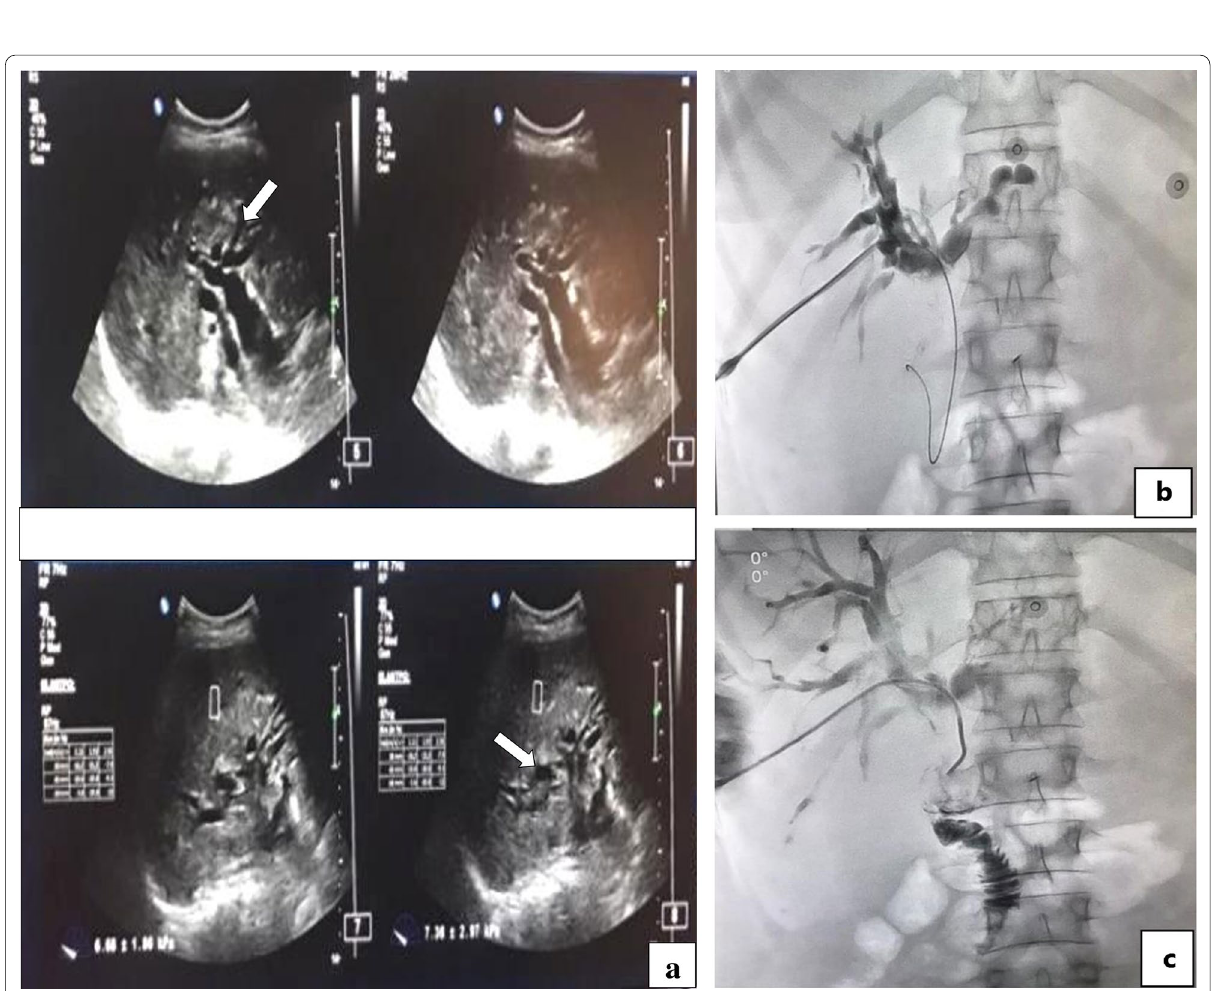
Fig. 5 A 40‑year‑old female patient with obstructive jaundice due to duodenal mass. a Shear wave elastography imaging before biliary drainage with moderate intrahepatic biliary radicles dilatation (IHBRD) (arrows). b Percutaneous transhepatic biliary cholangiogram shows biliary radicles dilatation. c Cholangiogram shows position of internal–external biliary catheter